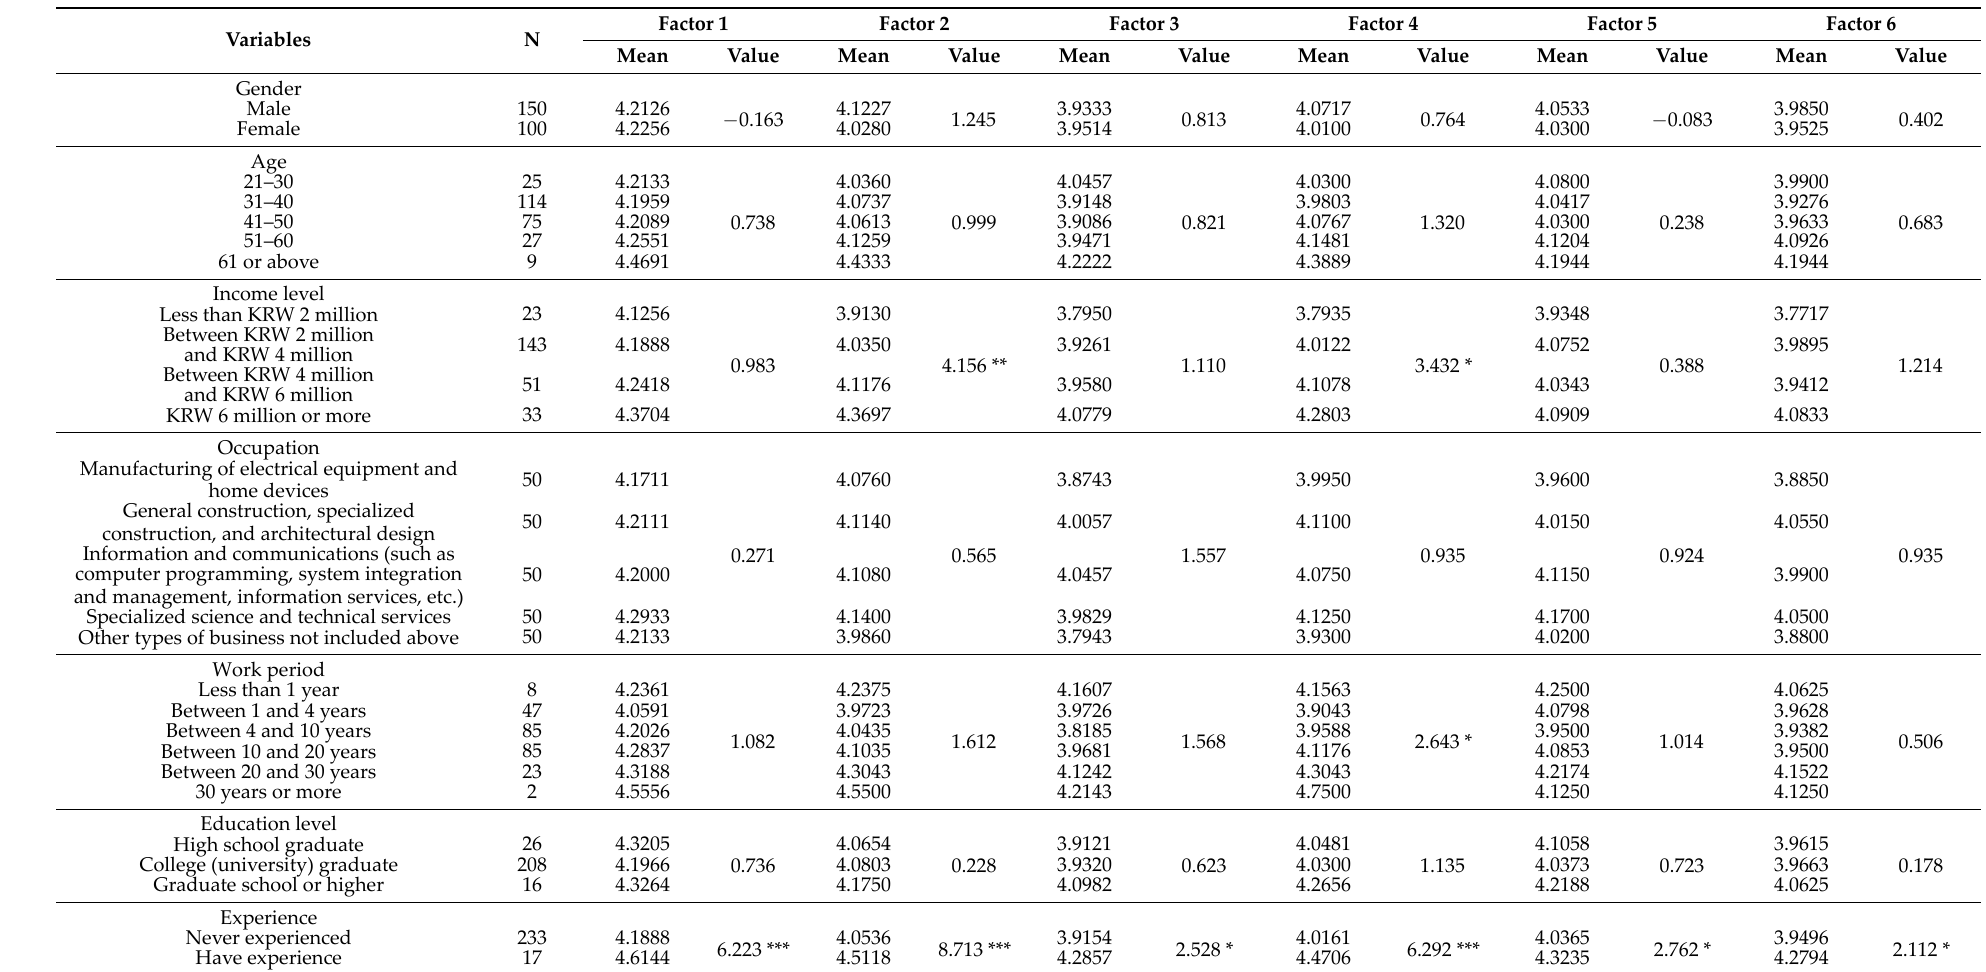
Table 7. Comparative analysis of means by factor (* p < 0.05, ** p < 0.01, *** p <